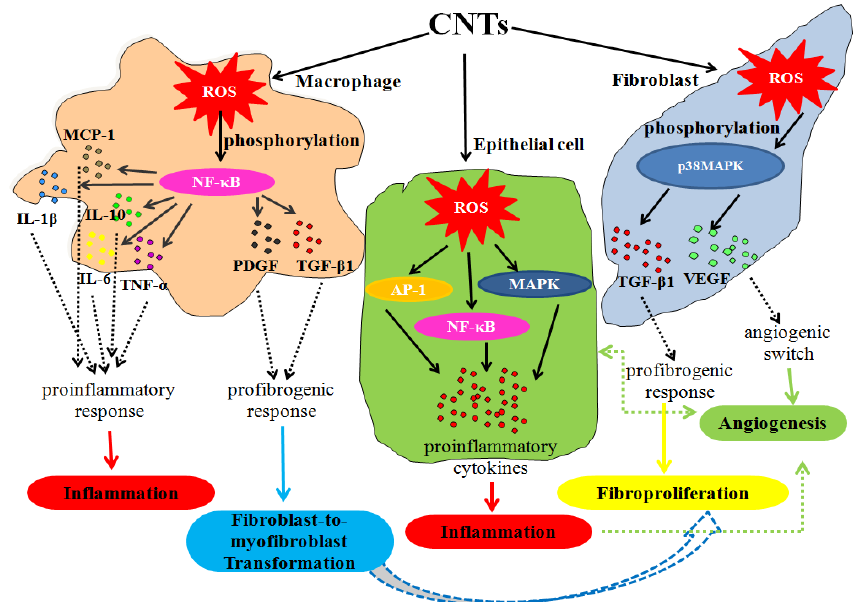
Figure 5. Cell signaling events induced by CNTs, original figure. In different cell types, CNTs induce reactive oxygen species (ROS)-dependent activation of certain cell signaling pathways (NF-κB, MAPK, AP-1), and subsequently, secretion of proinflammatory cytokines (in macrophages and epithelial cells) or profibrogenic and angiogenic factors (in macrophages and lung fibroblasts). Proinflammatory cytokines (IL-1β, IL-6, IL-10, TNF-α, MCP-1) are responsible for inflammation, profibrogenic factors (TGF-β1, PDGF) cause fibroproliferation and differentiation of fibroblast to myofibroblast, while growth factor (VEGF), as well as proinflammatory cytokines, initiates angiogenesis. (NF-nuclear factor, MAPK-mitogen-activated protein kinase, AP-activator protein, IL-interleukine, TNF-tumour necrosis factor, MCP-monocyte chemoattractant protein, TGF-transforming growth factor, PDGF-platelet-derived growth factor, VEGF-vascular endothelial growth factor).